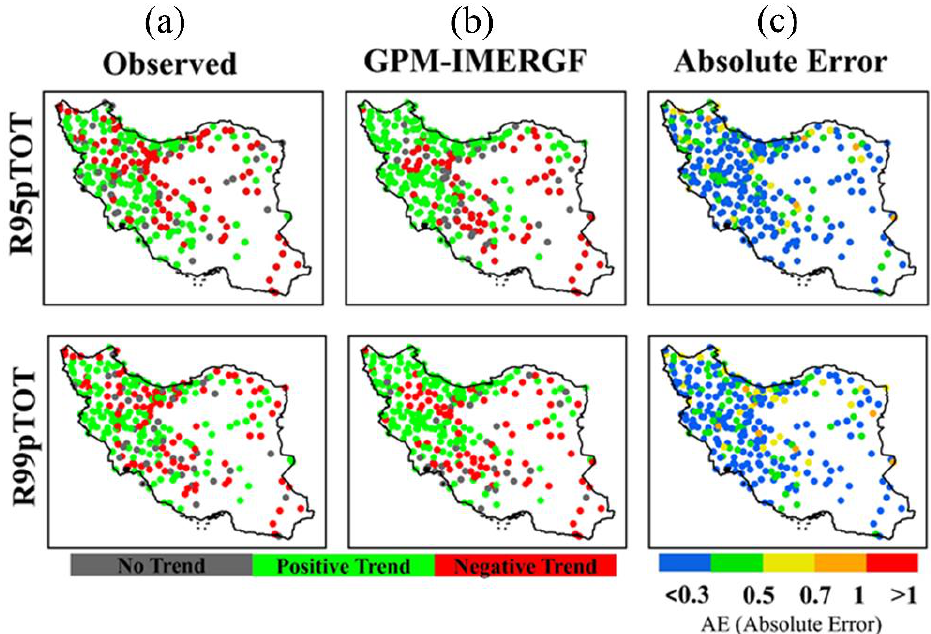
Figure 9. Percentile precipitation indices trends based on GPM-IMERGV6.0 Final Run (GPM- IMERGF) data and observational data. ( a – c ) are observational trends, GPM-IMERGF estimated trends, and absolute error between estimated Tau Kendall (Z score) and observed ones, respectively.